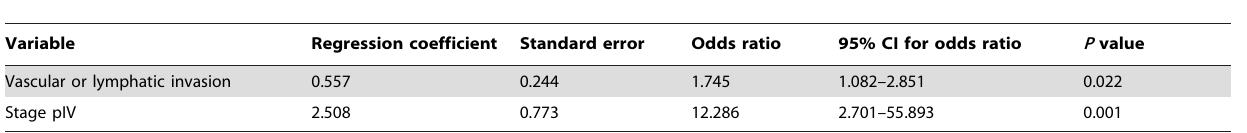
Table 3. Multivariate logistic regression analysis of risk factors for a positive proximal margin.